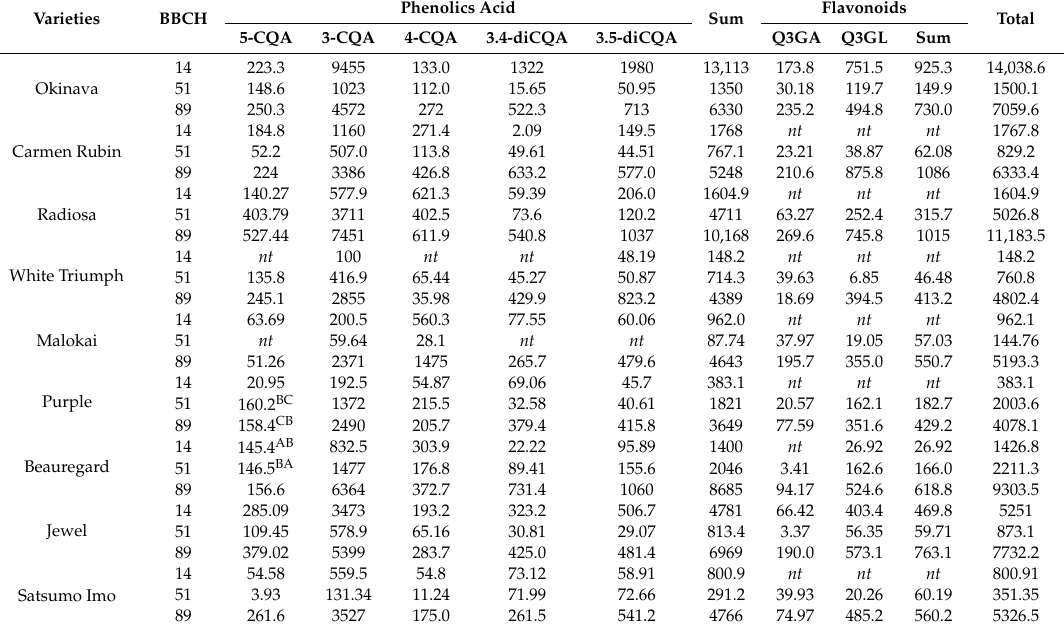
Figure 1. The total polyphenolic content was significantly di ff erentiated depending on the cultivar and leaf growth stage. The average content of the identified polyphenolic compounds in the cultivars − 1 under study ranged from 148.2 to 14038.6 mg / 100 g DM for leaves harvested at BBCH stage 14. Table 3. Polyphenolscontentinsweetpotatoleaves(mg100g − 1